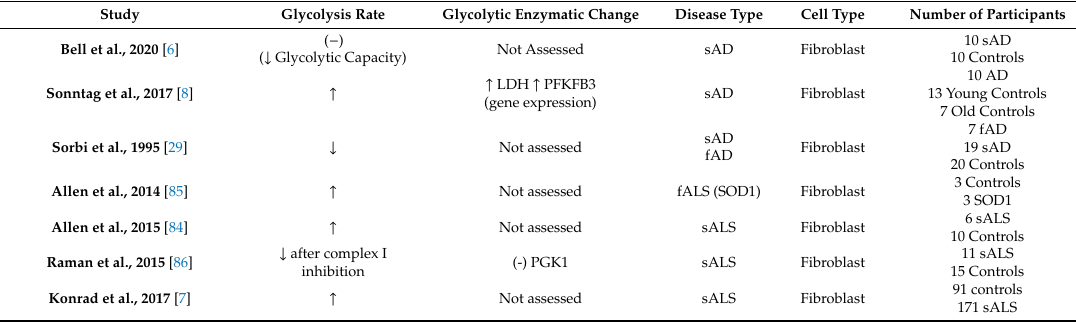
Table 1. Summary of peripheral glycolysis studies in neurodegenerative